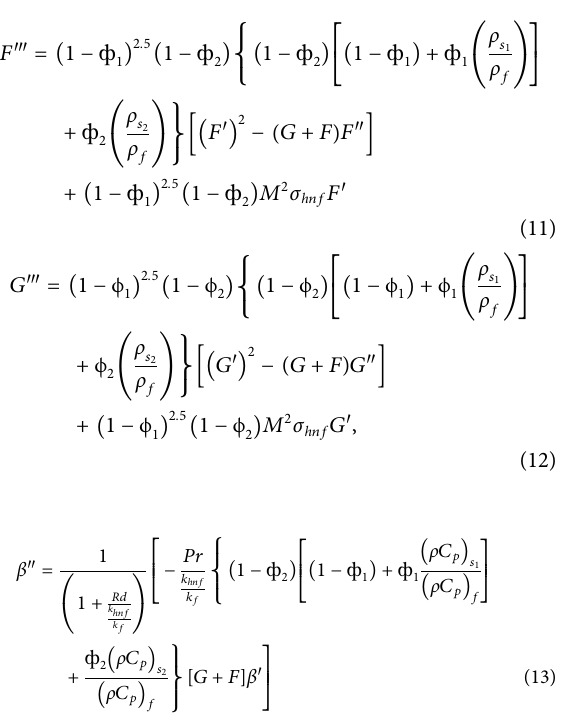
Furthermore, S t (cid:2) b / a (stretching parameter), M 2 (cid:2) σ B 2 p / a ρ f is the magnetic interaction parameter, Rd (cid:2) 16 σ p T 3 ∞ /3 k p k f is the Radiation parameter, and γ